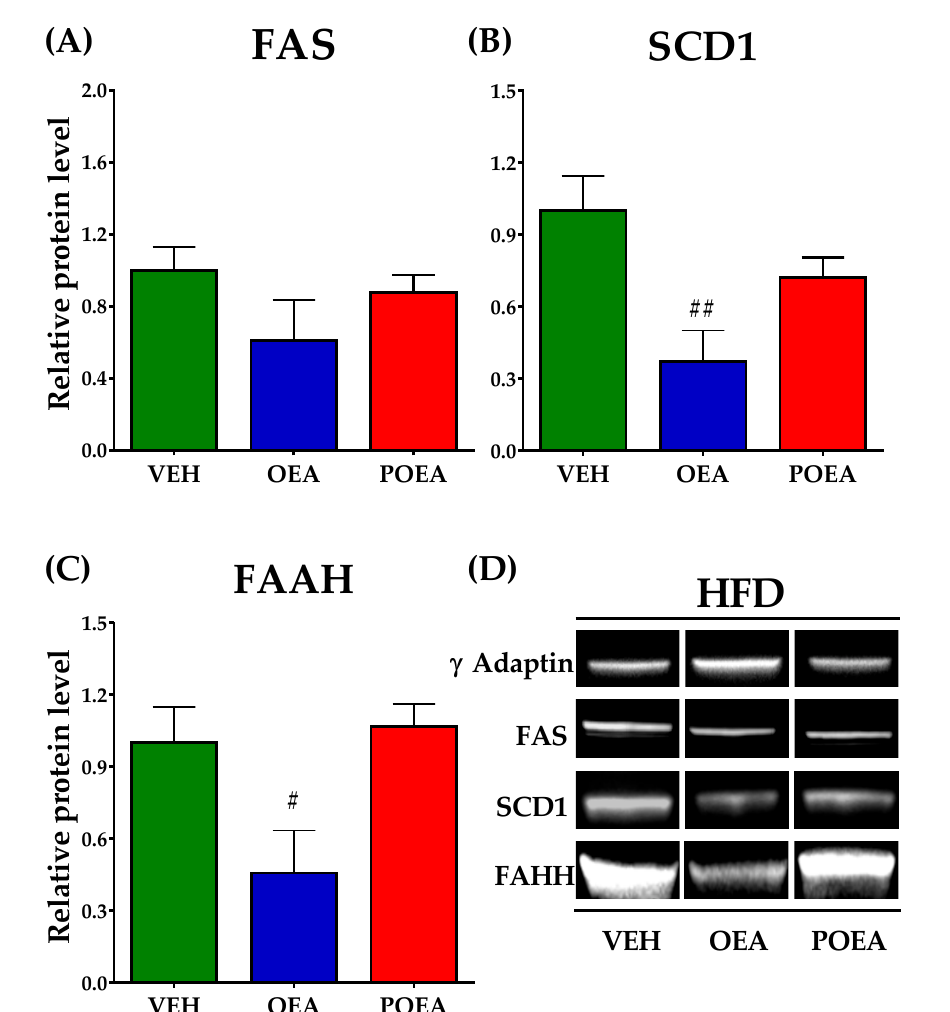
Figure 9. Analysis of protein expression after sub-chronic (15 days) administration of a 10 mg/kg dose of either N-acylethanolamines (NAEs) degrading enzyme after sub-chronic (15 days) administration of a 10 mg/kg dose of either oleoylethanolamide (OEA) or palmitoleylethanolamide (POEA) in liver in hypercaloric cafeteria diet (HFD)-fed Sprague–Dawley rats. Fatty acid synthase (FAS) ( A ), stearoyl-CoA desaturase (SCD1) ( B ), and fatty acid amide hydrolase (FAAH) ( C ) were analyzed by imaging densitometry. The bars show results from six independent samples from each treatment group. ( D ) Representative images of Western blot analysis of liver samples for each treatment. The corresponding expression of γ -adaptin is showed as a loading control per lane. All samples were derived at the same time and processed in parallel. The bars determined the means and corrected for γ -adaptin protein as reference ± standard error of the mean (SEM) ( n = 6 samples per group). Unpaired t -test: (#) p < 0.05 and (##) p < 0.01 vs. vehicle (VEH) group.